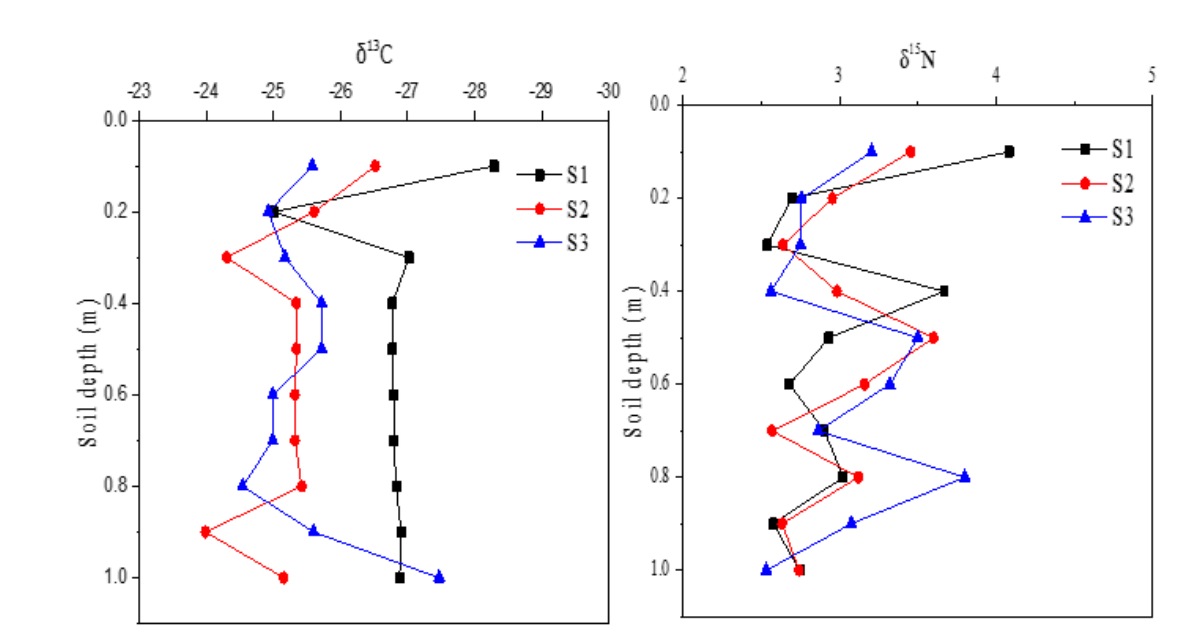
Figure 4. Depth-distributions of δ 13 C and δ 15 N in sediment cores near the constructed dam. (S1: upper-dam; S2: middle- dam; S3: bottom-dam positions).